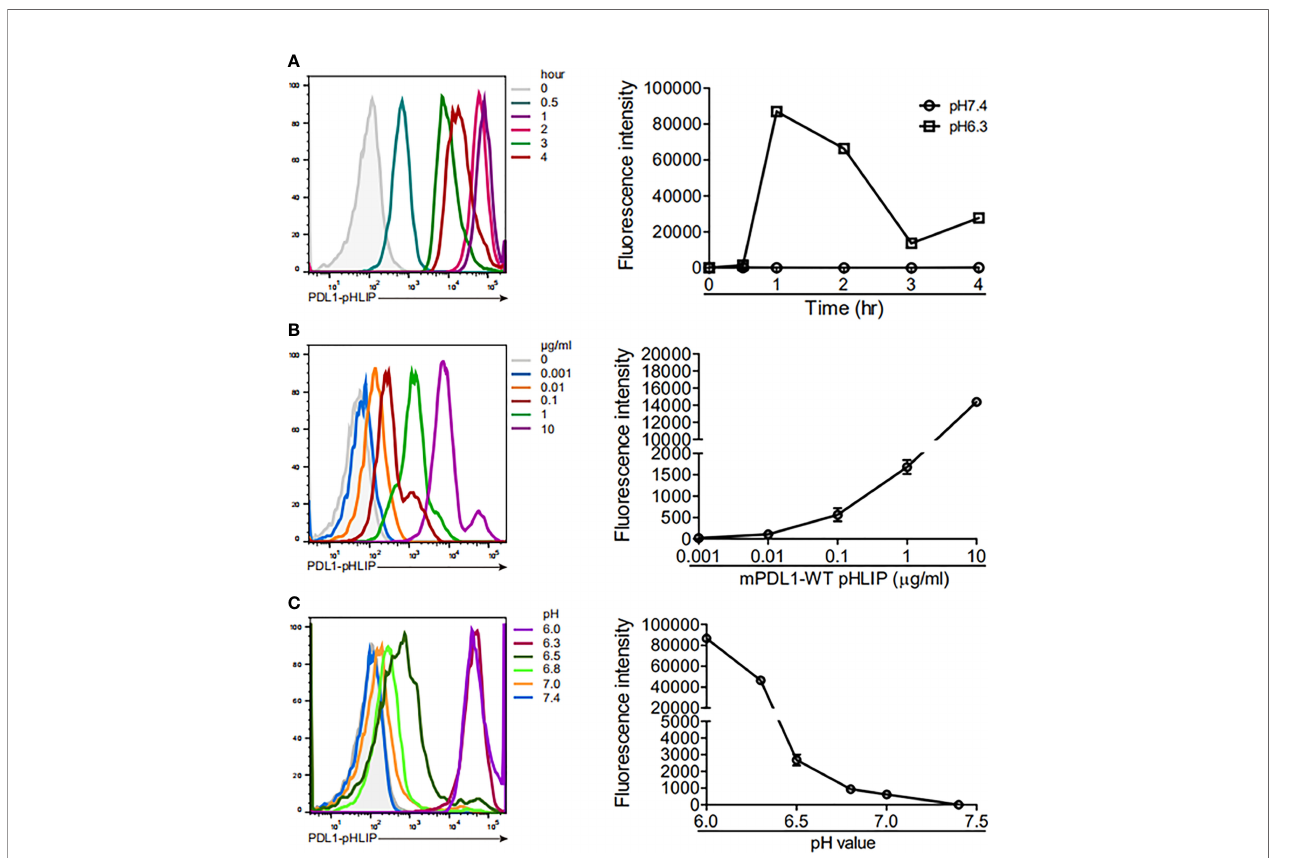
FIGURE 4 | The ability of PD-L1-pHLIP to span across cell membrane under titrated conditions. (A) THP-1 cell lines were incubated with PE-conjugated PD-L1- pHLIP (10 m g/ml) for 0 – 4 h in pH 6.3 buffer and then examined by fl ow cytometry. (B) PE-conjugated PDL1-pHLIP (0 – 10 m g/ml) were incubated with THP-1 cell line for 1 h in pH 6.3 buffer and then examined by fl ow cytometry. (C) THP-1 cell lines were incubated with PE-conjugated PD-L1-pHLIP (10 m g/ml) for 1 h in pH 6.0 – 7.4 buffer and then examined by fl ow cytometry. Left, representative plots from three independent experiments. Right, the data of fl uorescence intensity